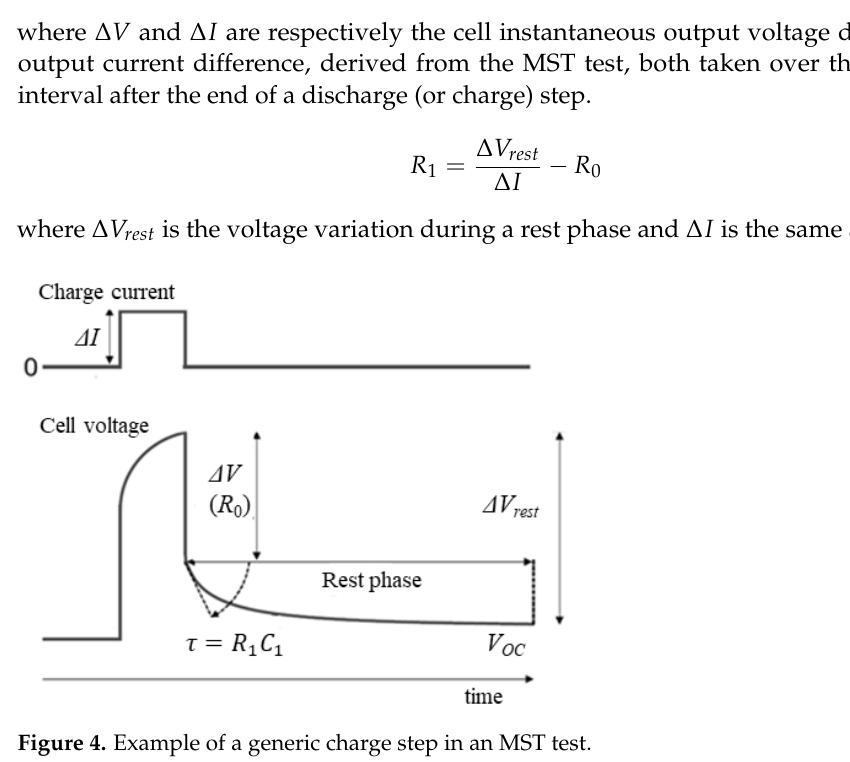
Figure 4. Example of a generic charge step in an MST test. Table 3. Electrical model parameters.